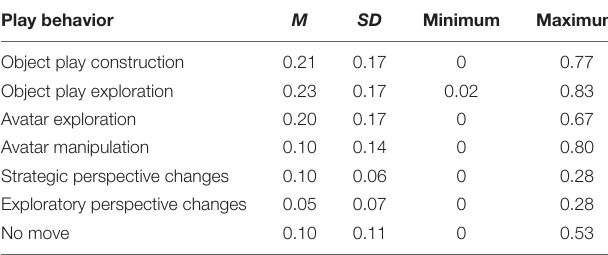
TABLE 2 | Means and standard deviations of the proportion of Toca Blocks play time children spent engaging in each play behavior.